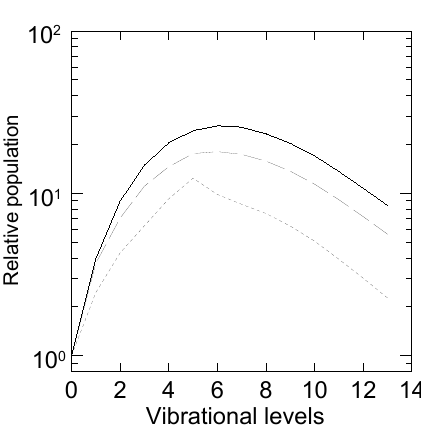
0 3 6 − u state of N 2